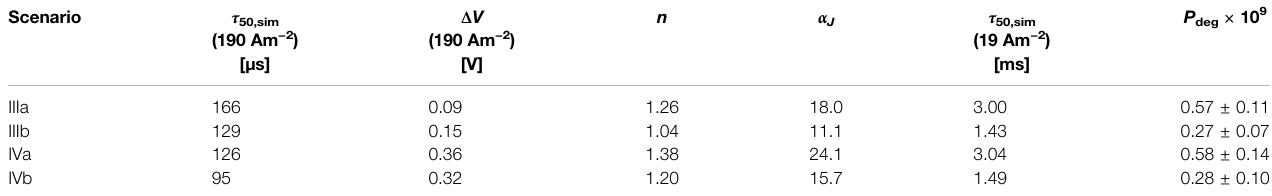
TABLE 2 | Results and analysis of degradation simulations for scenarios III(a,b) and IV(a,b) at accelerated current conditions ( J acc (cid:2) 190 Am − 2 ) and P deg,sim (cid:2) 1. The simulations yield a lifetime τ 50,sim ( J acc ) and a voltage increase Δ V at t (cid:2) τ 50,sim ( J acc ). Extrapolation using the calculated acceleration exponent n (see Section 3.3.2 ), yielding an acceleration factor α J (see Eq. 2 ), leads to τ 50,sim ( J 0 ), with J 0 (cid:2) 19 Am − 2 the current density at which an experimental lifetime of 1,470 h has been obtained (Furukawa et al., 2015). With Eq. 1 , the simulated and experimental lifetimes at J 0 are used to calculate the effective degradation probability per triggering event, P deg . Scenario